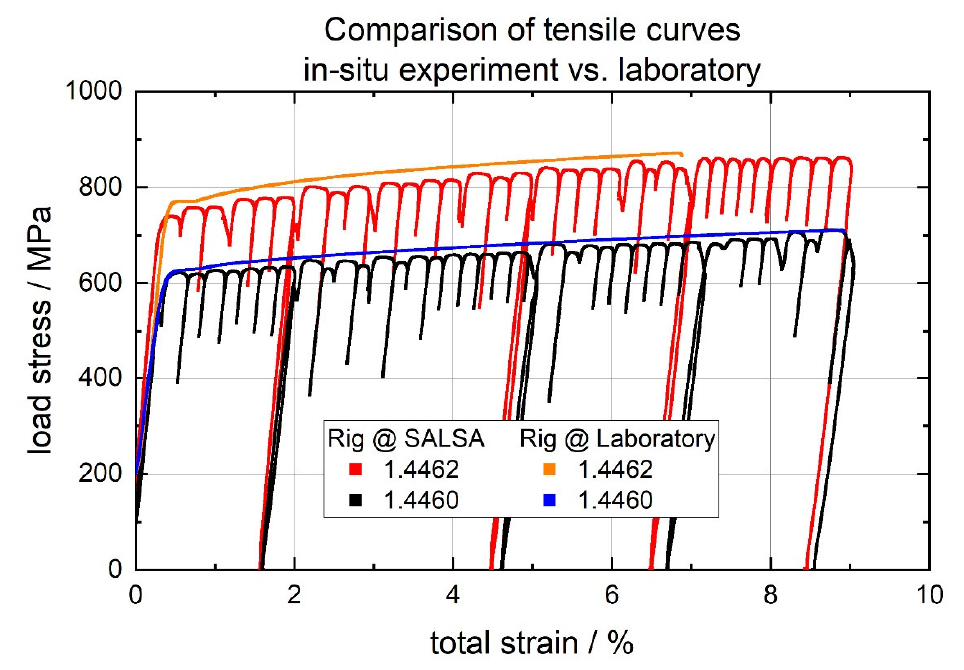
Figure 5. Experimental set-up used at SALSA for the in situ diffraction experiment during uniaxial tensile loading for the longitudinal component.